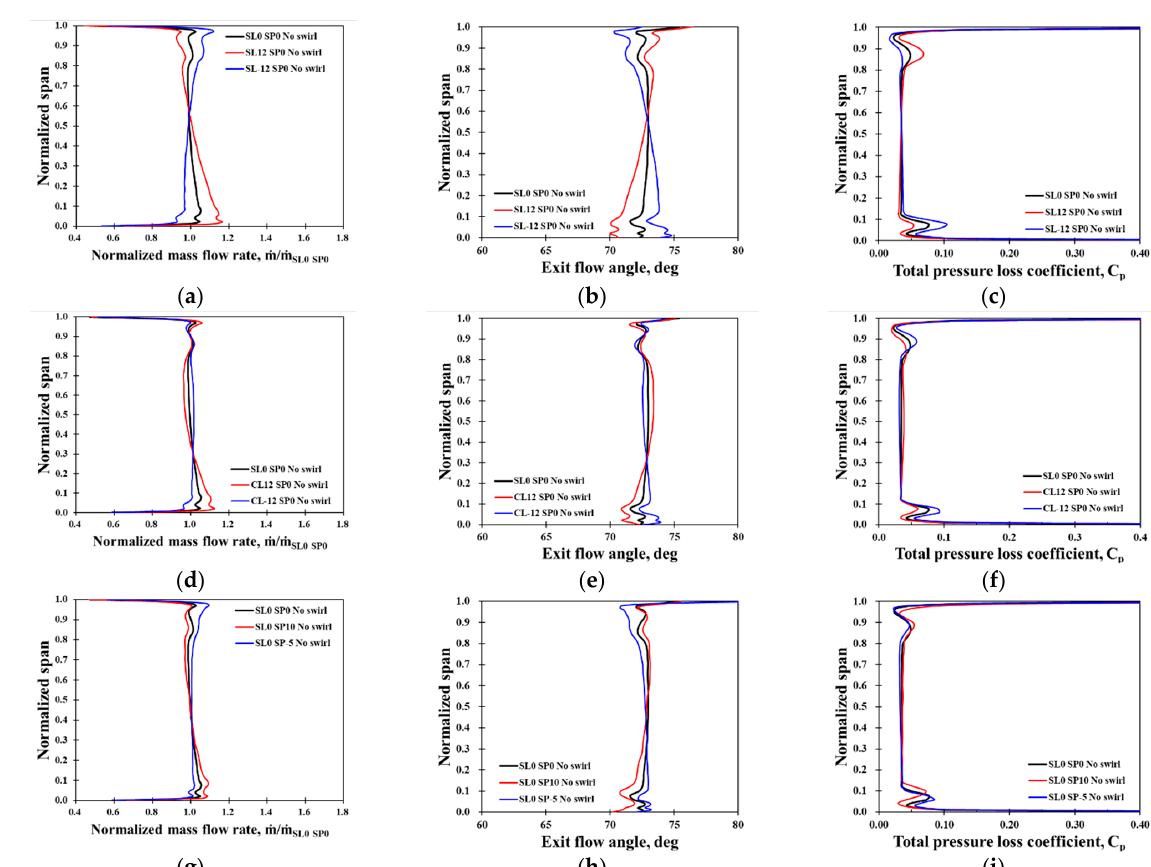
Figure 11. Comparison of circumferentially averaged static pressure, exit flow angle, and total pressure loss coefficient due to the straight lean, compound lean and sweep: ( a ) Static pressure with straight lean; ( b ) Flow angle with straight lean; ( c ) Total pressure loss with straight lean; ( d ) Static pressure with compound lean; ( e ) Flow angle with compound lean; ( f ) Total pressure loss with compound lean; ( g ) Static pressure with sweep; ( h ) Flow angle with sweep; ( i ) Total pressure loss with sweep.